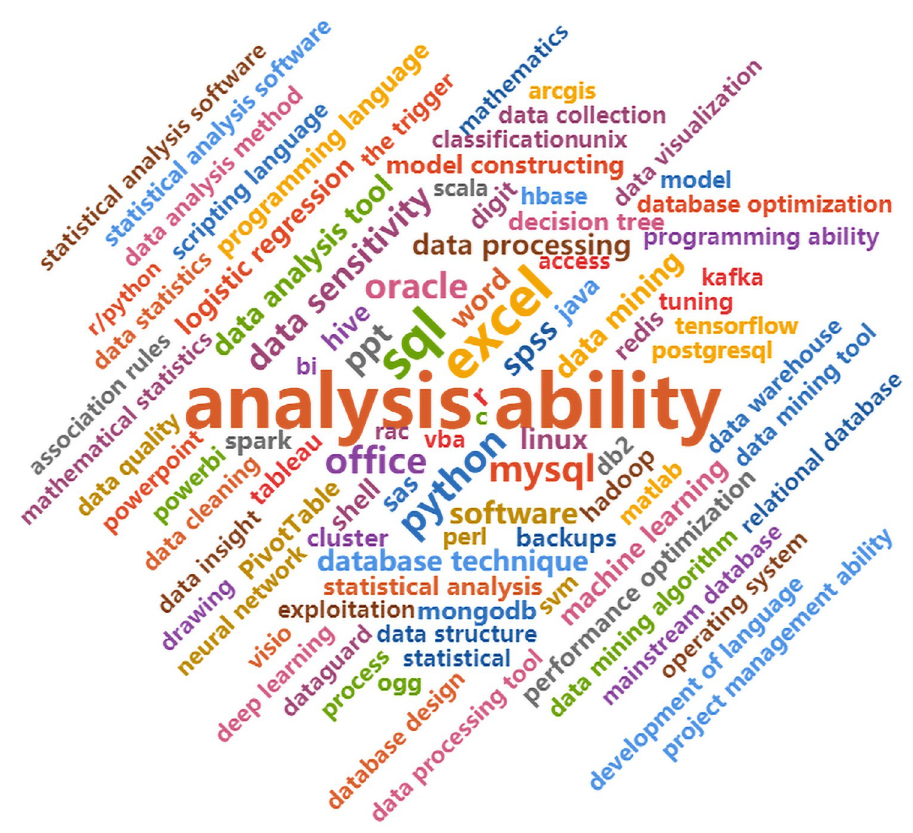
Fig 6. Cloud map of professional skill